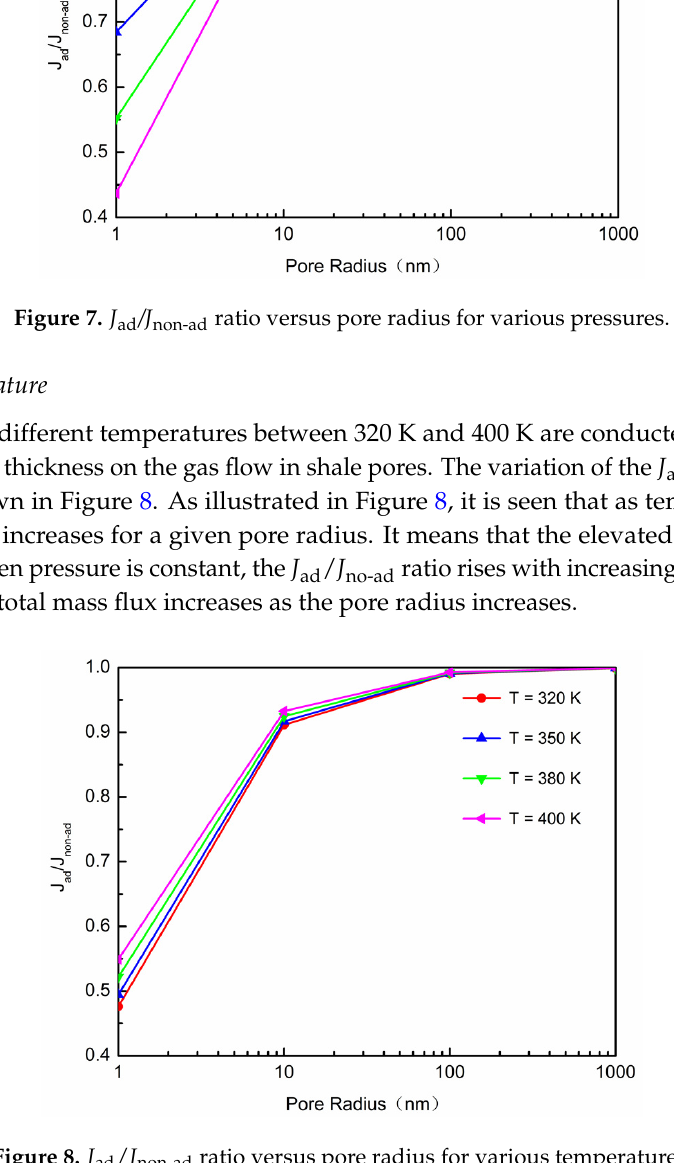
Figure 8. J ad / J non-ad ratio versus pore radius for various temperatures.